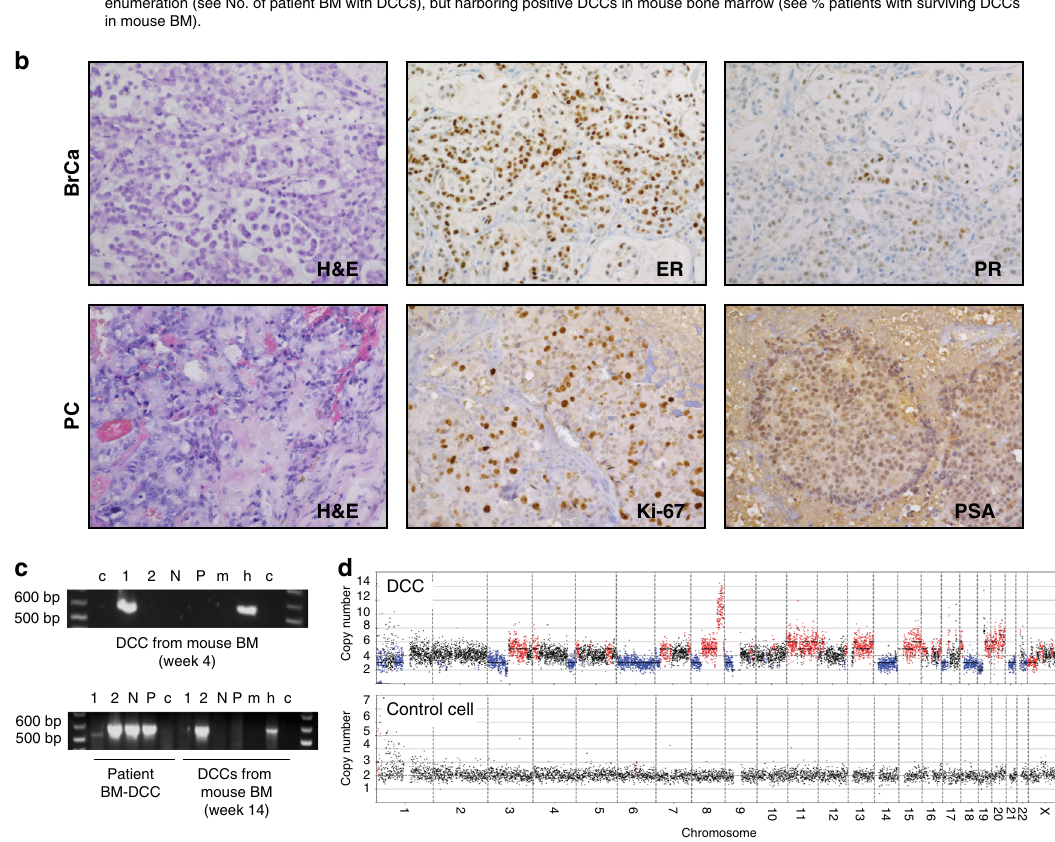
con fi rmed malignant origin 14 . We followed the reasoning that epithelial cell identity in BM of a cancer patient plus the presence of genetic alterations is suf fi cient to claim malignant epithelial origin or malignant potential of a cell. DCCs were detected by screening diagnostic BM aspirates from 246 M0-stage and 18 M1- stage patients for cells that stained positively for the epithelial marker EpCAM (Supplementary Fig. 1a). Forty percent of